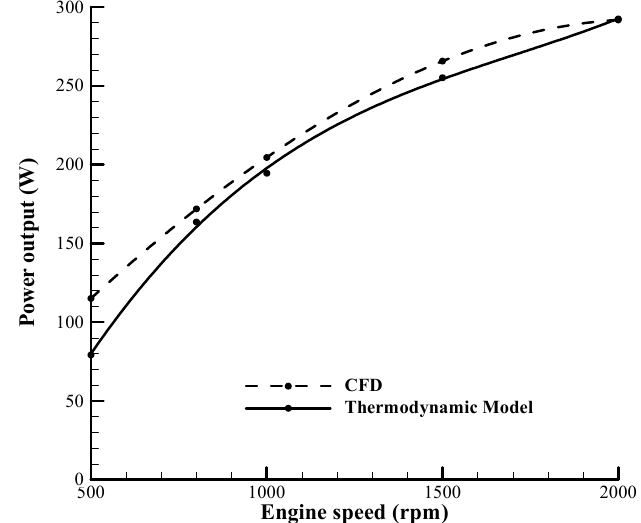
Figure 6. Comparison between thermodynamic model and CFD analysis in indicated power output.